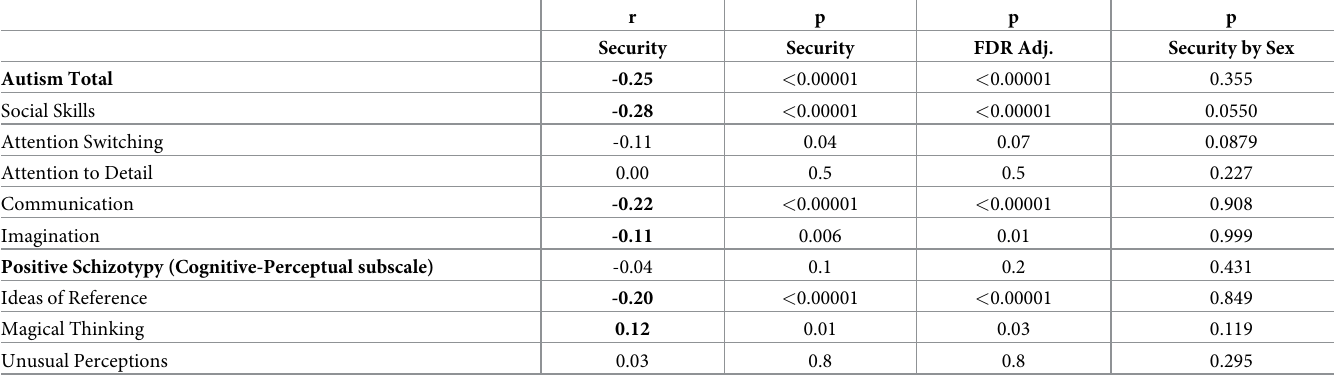
Table 6. Correlations of security with autism and schizotypal traits, and results from ANCOVAs testing for sex by trait interaction effects. r